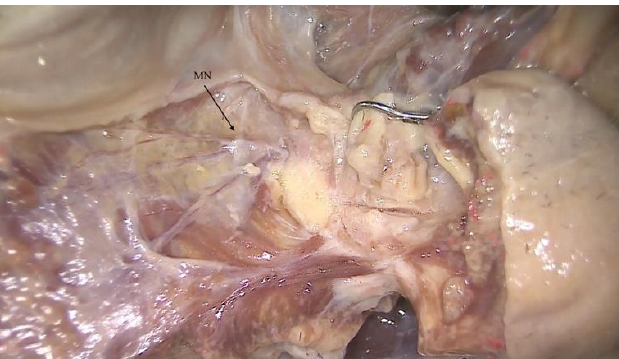
Figure 1. Anatomical pictures of a human body dissection showing the mental nerve fiber (MN), which is a common target of anesthesia before performing surgery in the mandibular symphysis.